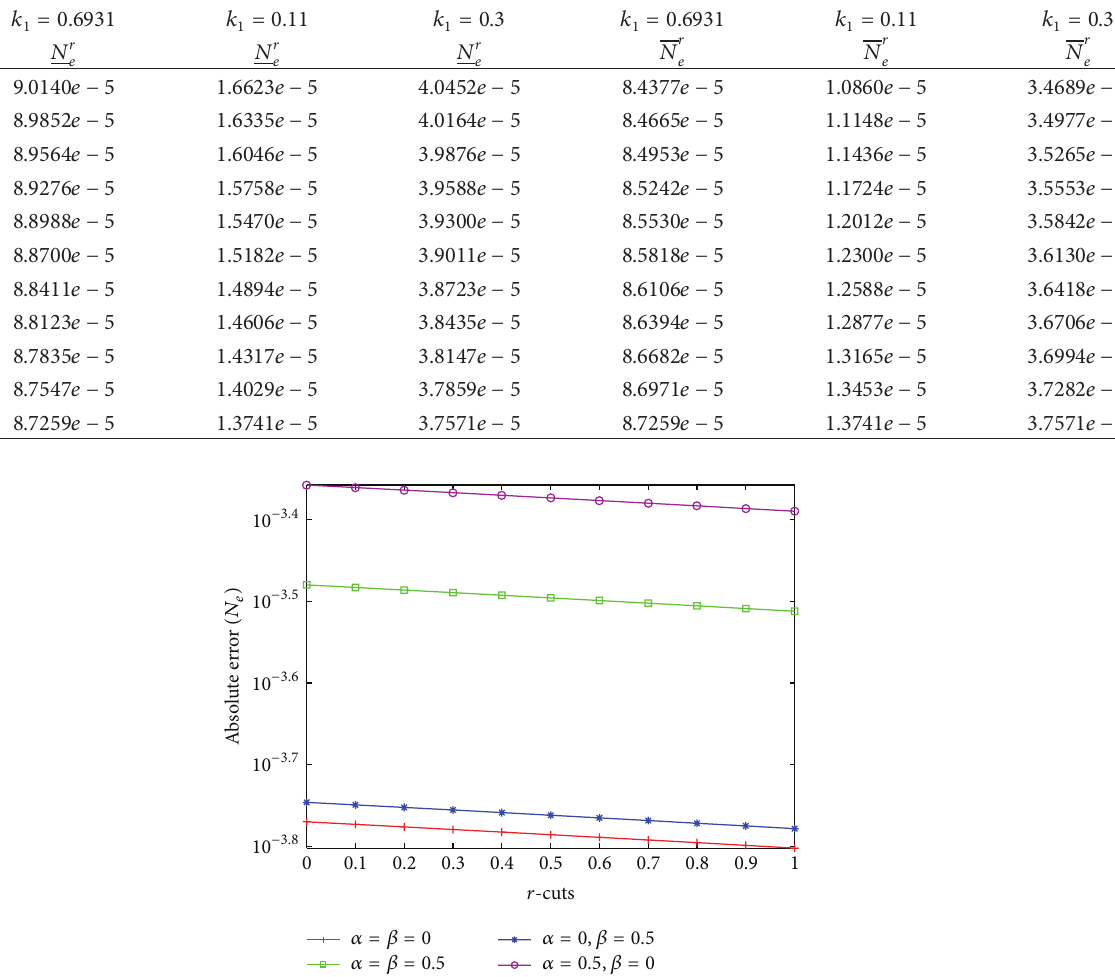
Table 1: The results of the proposed method for Case I with V = 0.85 , 𝛼 = 𝛽 = 0 , and 𝑁 = 8 .